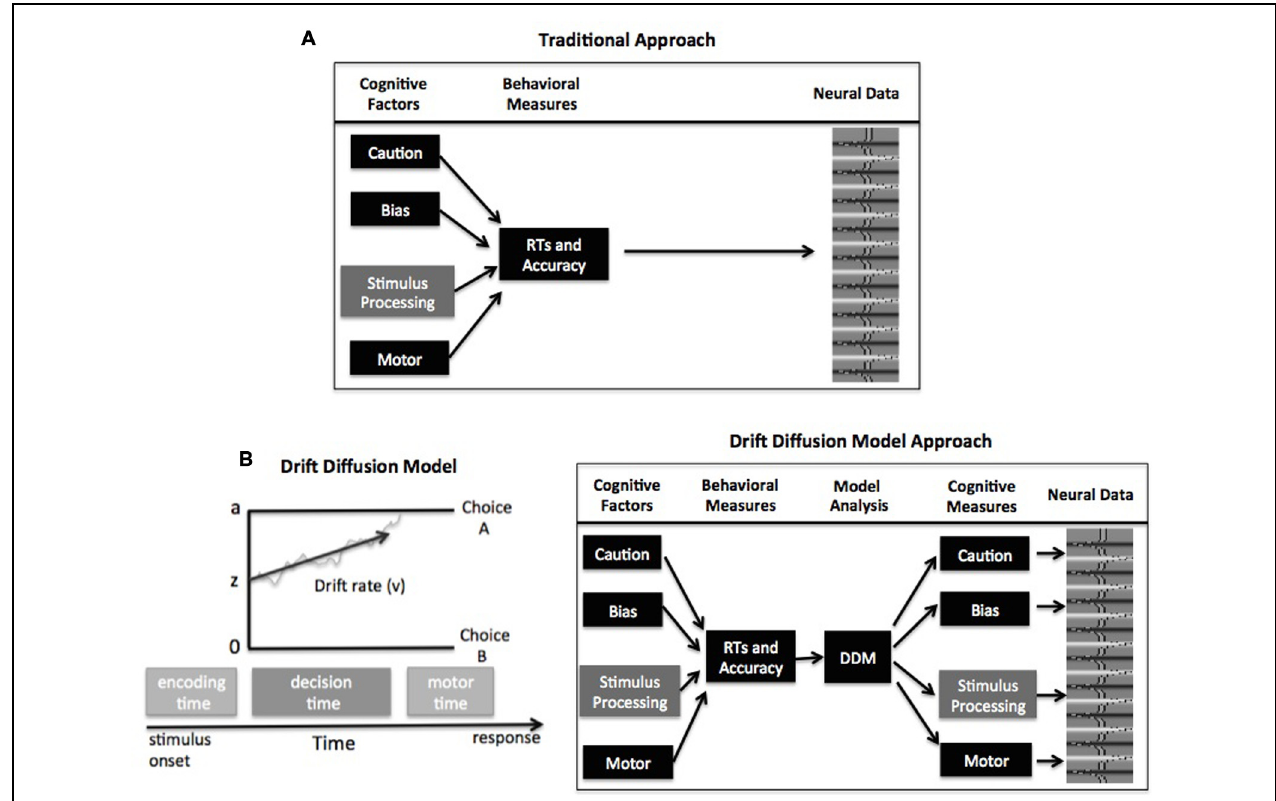
FIGURE 1 | (A) Schematic of traditional analyses relating task performance to neural activity. (B) Schematic of the drift–diffusion model (DDM; left) and model-based analysis for relating cognitive mechanisms to neural activity (right). See text for description of model